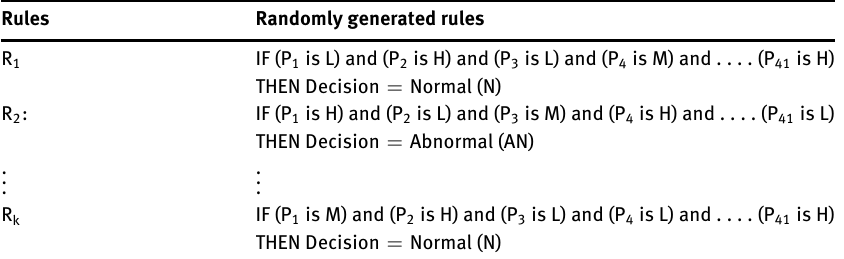
Table 4: Solution